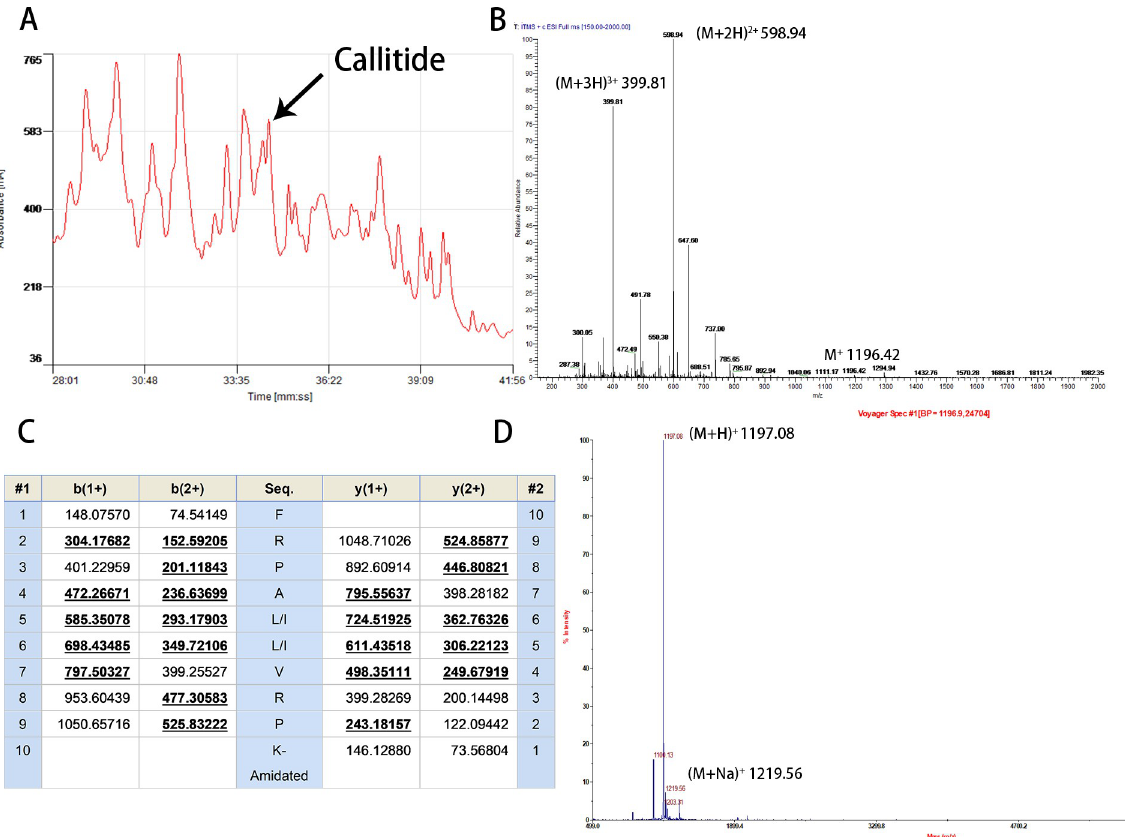
Fig 2. Sepration and identification of callitide mature peptide. (A) Region of reverse phase HPLC chromatogram of Agalychnis callidryas skin secretion. The arrow indicates the elution position of peak (#35) containing the myotropic decapeptide callitide; (B) LCQ mass spectrum of callitide from the skin secretion of Agalychnis callidryas . Ions at m/z 598.94 and 399.81 represent doubly charged (M+2H) 2+ and triply charged (M+3H) 3+ ions, respectively; (C) Electrospray ion-trap MS/MS fragmentation datasets derived from ions corresponding in molecular mass to callitide. Expected singly-, doubly- and triply- charged b-ion and y-ion fragment m/z ratios were predicted and observed fragment ions are indicated in bold type-face and are underlined; (D) MALDI-TOF mass spectrum of synthetic copy of